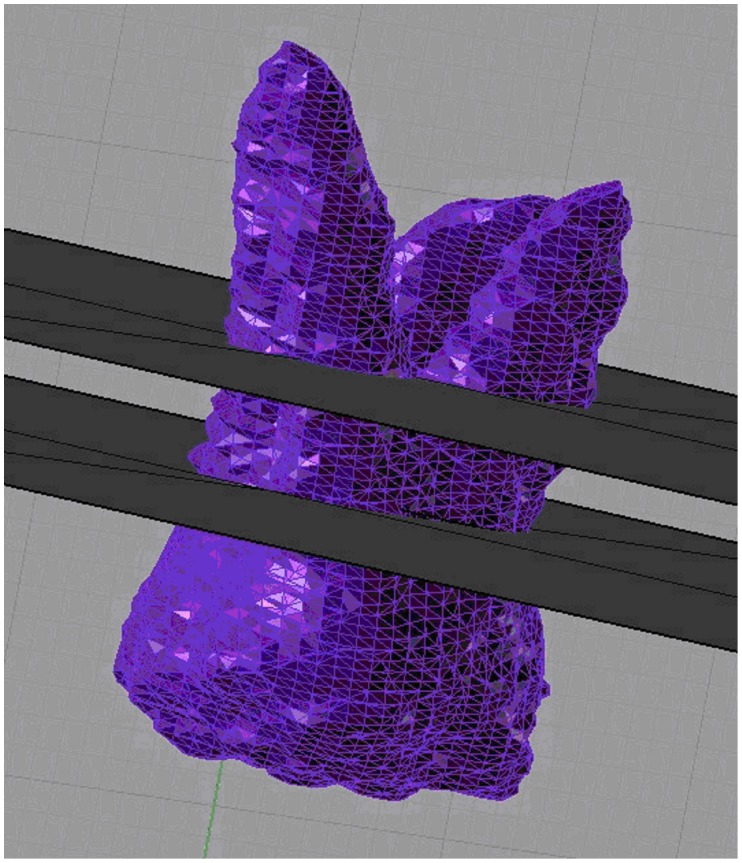
Construction of the reference plane.The plane parallel to the cement-enamel junction and passing through the deepest point of the furcation between these roots.